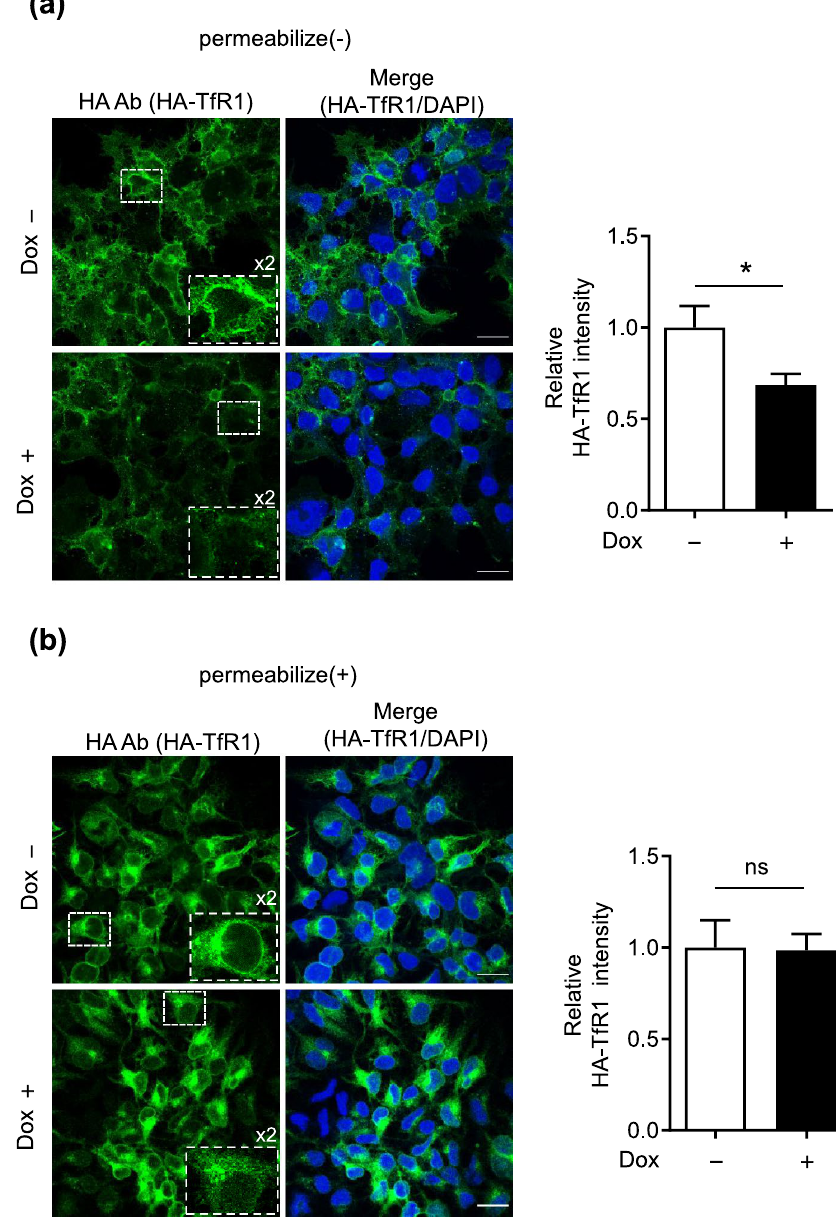
Figure 6. Effects of ATRAP expression on the cell-surface abundance of the TfR1 protein. Immunofluorescence staining analysis of ( a ) cell-surface or ( b ) total HA-TfR1 expression in HA-TfR1 expressing Dox-inducible HEK293_F-mATRAP cells with an anti-HA antibody, with or without Dox treatment (Dox+/−). The cells were fixed with 4% paraformaldehyde without permeabilization ( a : cell-surface TfR1) or with permeabilization ( b : total TfR1). Green: HA-TfR1, Blue: DAPI. Scale bars: 20 μm. Quantitative analysis was performed based on the sum of the HA-TfR1-staining intensity/DAPI counts. The data shown in graphs are presented as the mean ± SEM. Unpaired t -test: * p < 0.05 vs. Dox + cells (n =